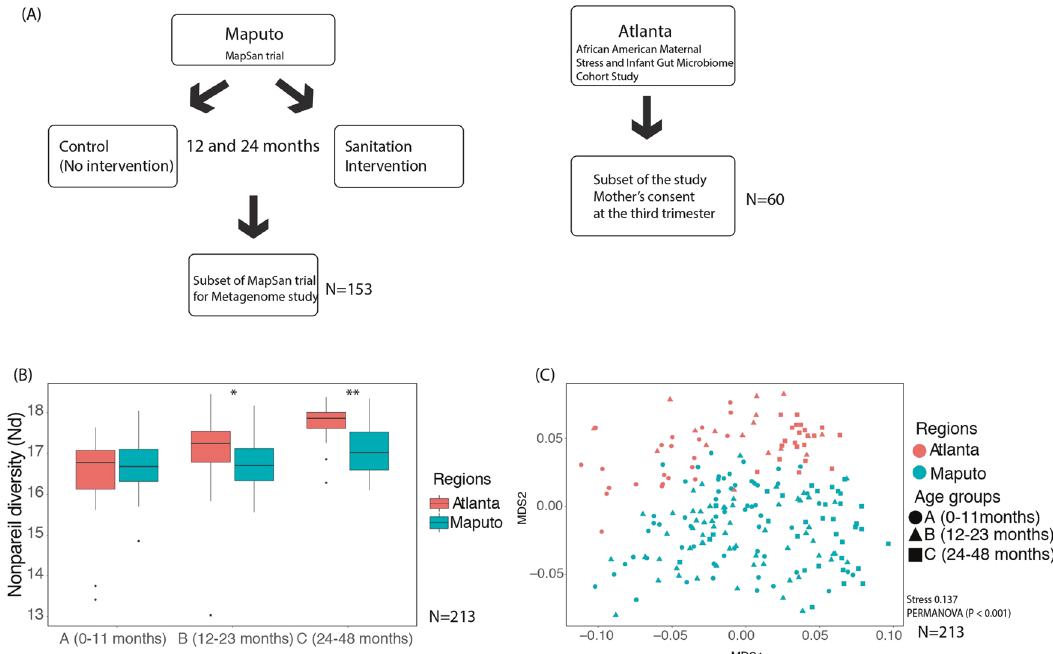
Fig. 1 A fl ow-chart of the study design and microbial community diversity patterns between Atlanta and Maputo gut microbiomes. A A fl ow chart summarizing the samples analyzed from the MapSan trial and the African American Maternal Stress and Infant Gut Microbiome Cohort studies B Nonpareil diversity ( N d ) of the samples used in this study ( n = 213) (*Signi fi cantly different at P adj < 0.05, ** P adj < 0.01, Dunn ’ s post-hoc test). C A non-metric multidimensional scaling (NMDS) plot of microbial community similarity based on MASH distances of whole metagenomes, colored-code by city (Atlanta vs Maputo) and age (see key). Names starting with A denote the 0 – 11 month child group, B the 12 – 23 month group, and C the 24 – 48 month group (e.g., A_ATL indicates Atlanta children samples 0 – 11 months old in